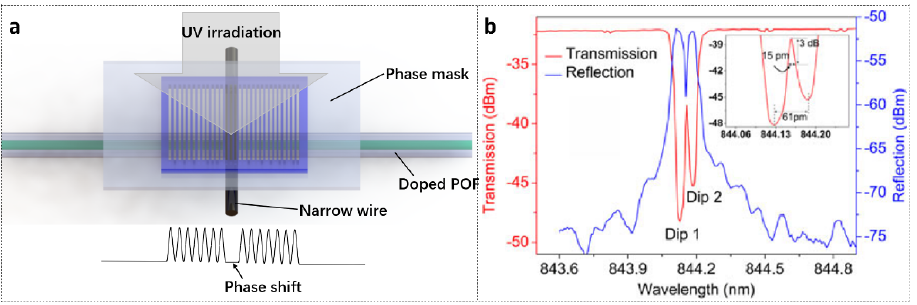
Figure 15. ( a ) Schematic configuration of PSFBG inscribed with a narrow metal wire positioned in the center of the UV beam. ( b ) Transmitted and reflected amplitude spectra of PSFBG inscribed by a single UV pulse. Reprinted with permission from [77].